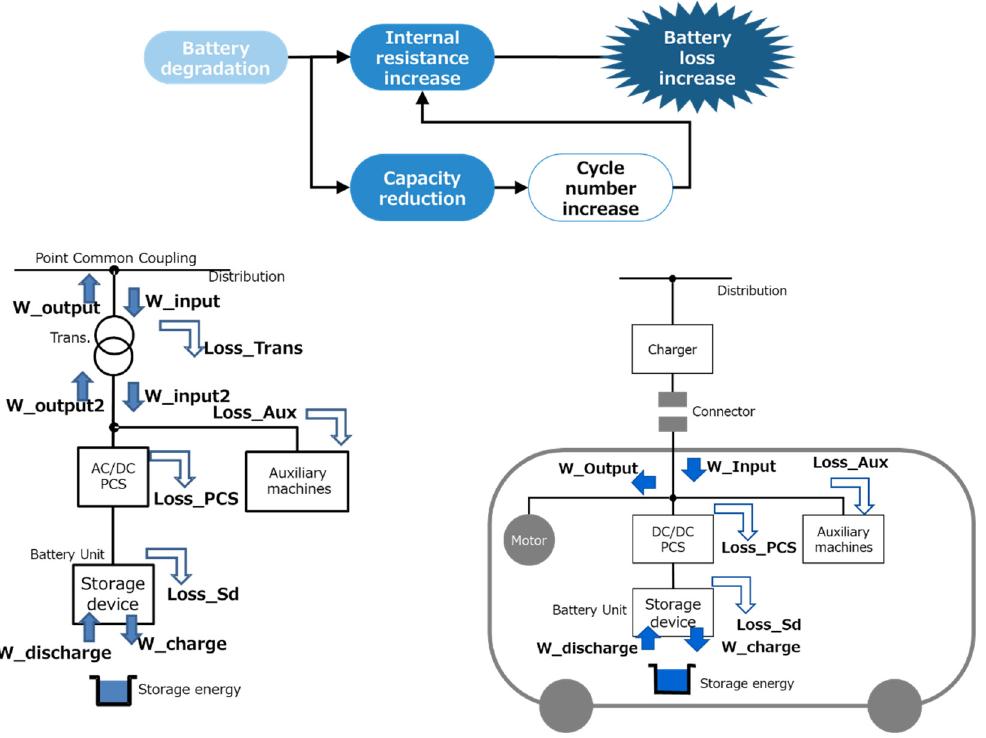
Figure 2. Simplified b attery system configuration and losses.